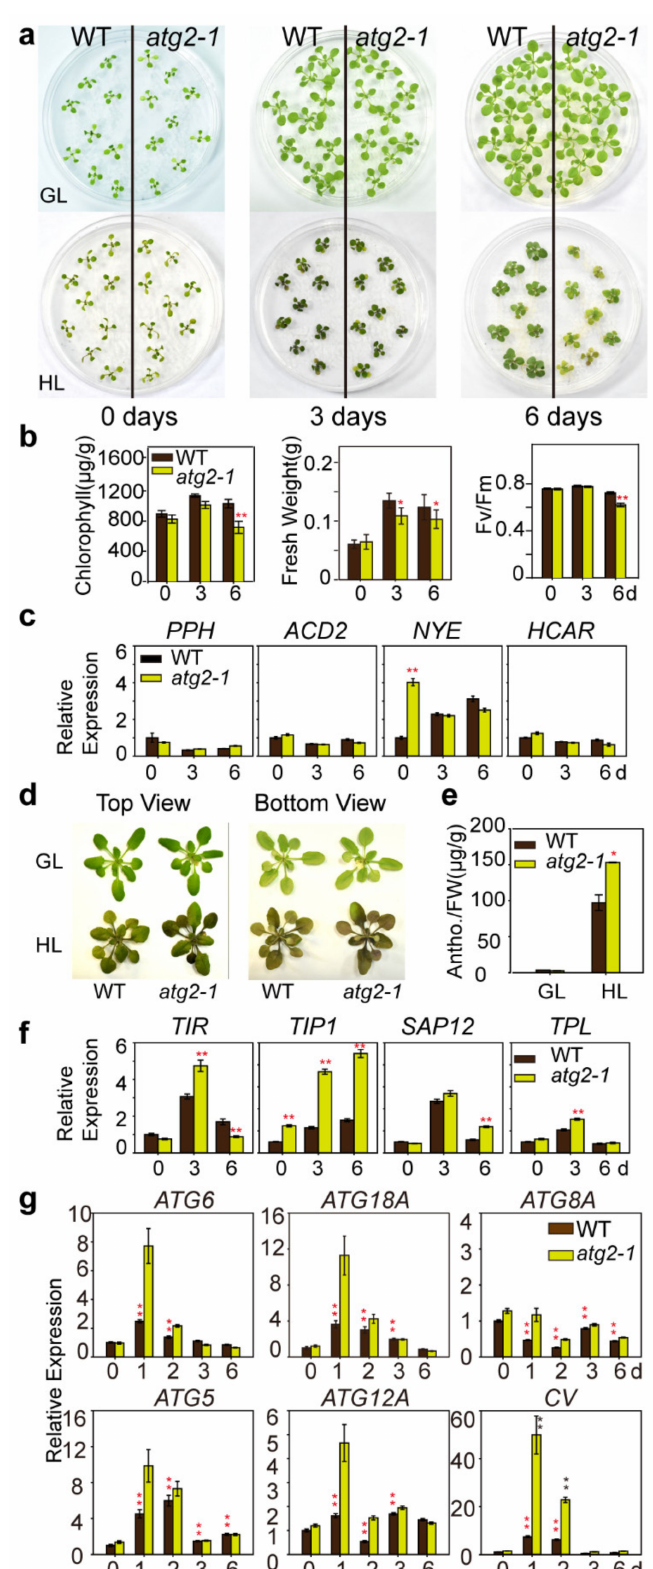
Figure 6. Characterization of ATG2 -deficient plants under high light intensity conditions. ( a ) Ten-day-old WT and atg2-1 mutant plants grown under growth light intensity (GL, 80 µ mol · m − 2 · s − 1 ) and high